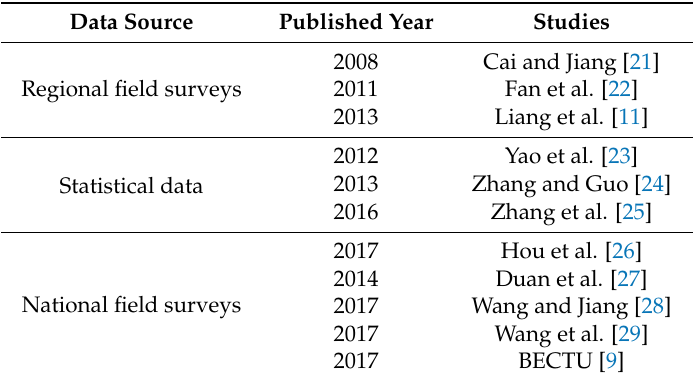
Table 1. Some studies about rural energy consumption in